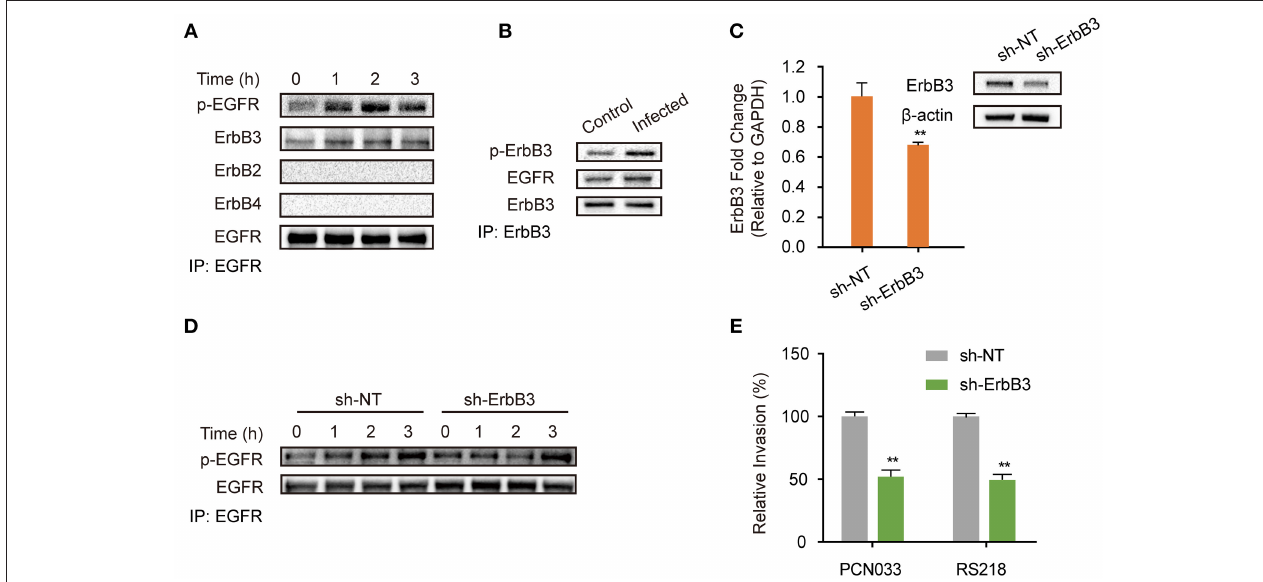
FIGURE 2 | EGFR-ErbB3 dimerization induced by meningitic E. coli is important for EGFR activation and bacterial invasion of hBMECs. (A) Identification of the possible dimers involved in the EGFR response to meningitic E. coli infection. Infected cell lysates were immunoprecipitated with the anti-EGFR antibody, and then subjected to western blotting with different antibodies against ErbB. (B) Verification of the association between ErbB3 and EGFR via immunoprecipitation experiments with the anti-ErbB3 antibody. The hBMECs were challenged with PCN033 for 3 h. (C) Knock-down and verifying ErbB3 expression levels in hBMECs via the shRNA approach. β -actin and GAPDH were used as the endogenous controls for western blotting and quantitative PCR. (D) Comparison of the infection-induced EGFR activation in the control cells and the ErbB3 knocked-down cells. (E) Effect of the ErbB3 knock-down on meningitic E. coli (PCN033 and RS218 strains) invasion of hBMECs. ** p <